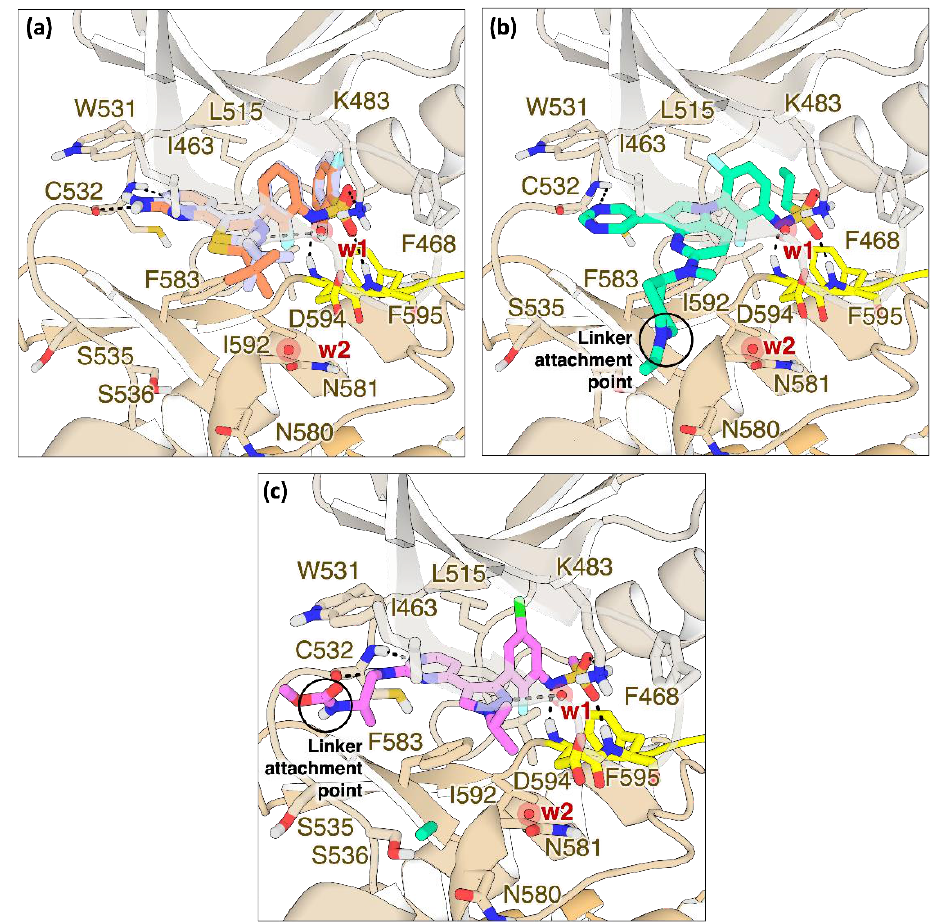
Figure 8. Self-docking of dabrafenib superposed to dabrafenib crystal pose ( a ) and docking poses of ( b ) BI 882730 and ( c ) encorafenib in BRAF V600E . In ( a ), the dabrafenib docking pose is colored lilac, while X-ray binding pose (PDB ID: 5CSW) is colored orange. In ( b ), BI 882730 (green) and in ( c ) encorafenib (pink) ligands are depicted as sticks; the linker attachment point for obtaining P5B and 10 is encircled and labelled. Waters retained in docking are shown as red spheres and labelled as ‘w1’ and ‘w2’, hydrogen bonds are shown as dashed black lines and non-polar hydrogens are omitted for clarity. Protein is represented as cartoon and colored in beige, binding site residues are shown as sticks and labelled with one letter code and the DFG loop is highlighted in yellow.